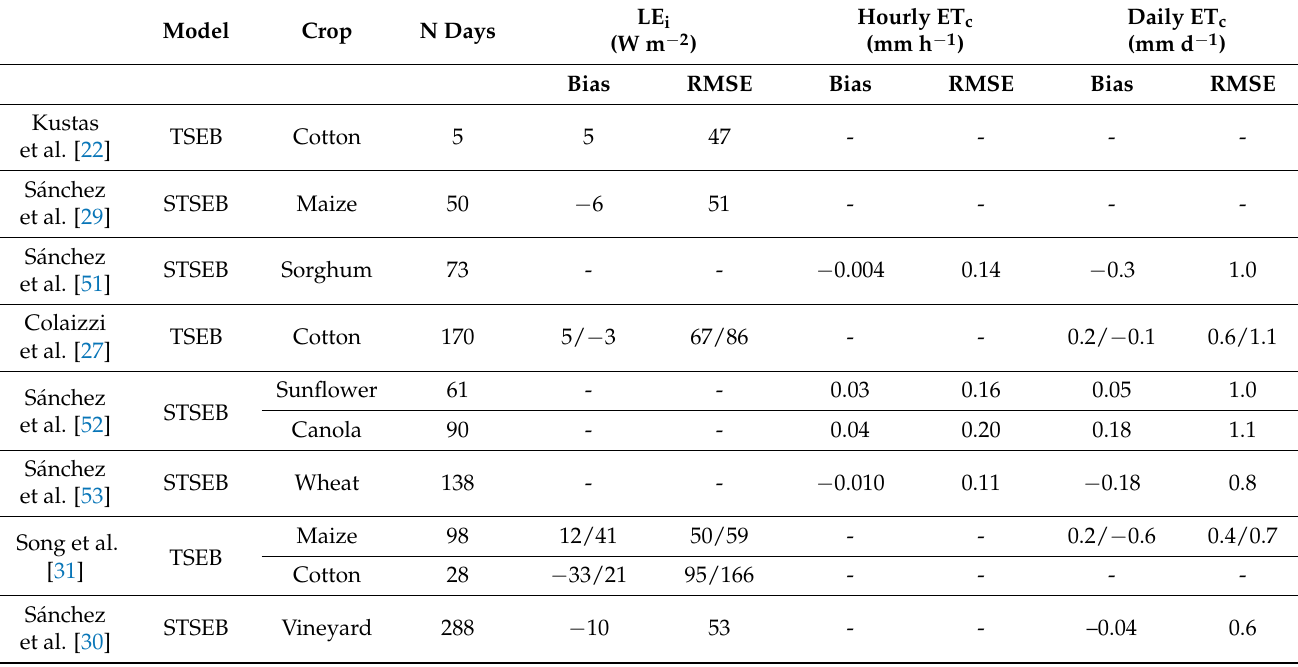
Table 4. Summary of the statistics for some assessments of the two-source energy balance scheme combined with radiometric surface temperatures, reported in the literature over different croplands, using eddy-covariance (LE) or weighing lysimeter measurements (Hourly and Daily ET c ) as a